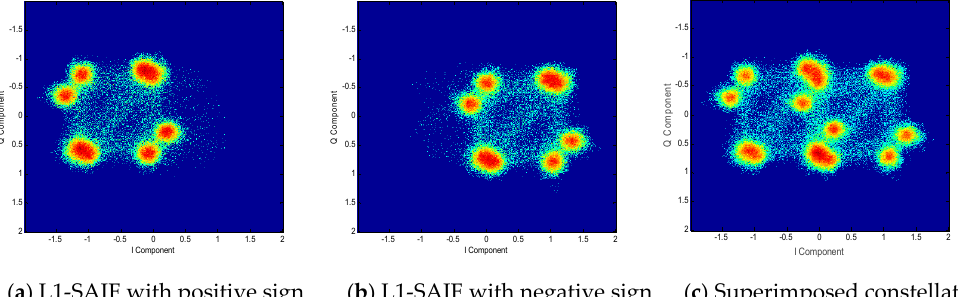
Figure 11. QZS-2 satellite L1 frequency point signal constellation.